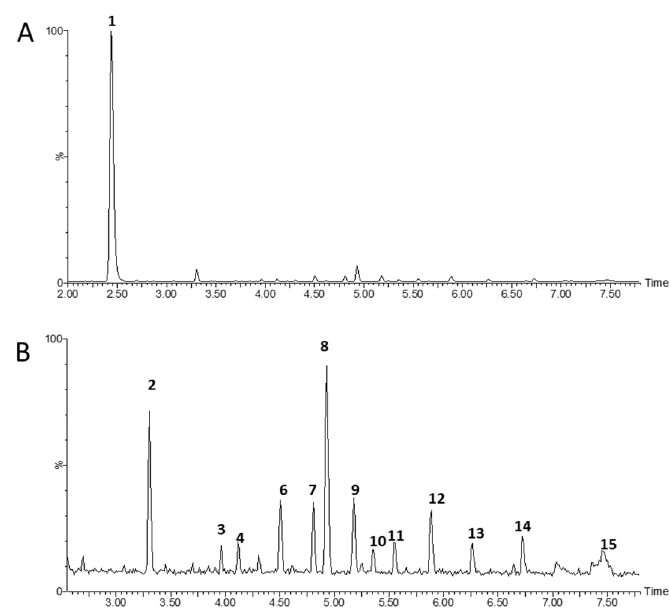
Figure 2. UPLC-MS chromatogram of one representative R. coriaria sample, which shows that the presence of gallic acid derivatives B is a detail of A .